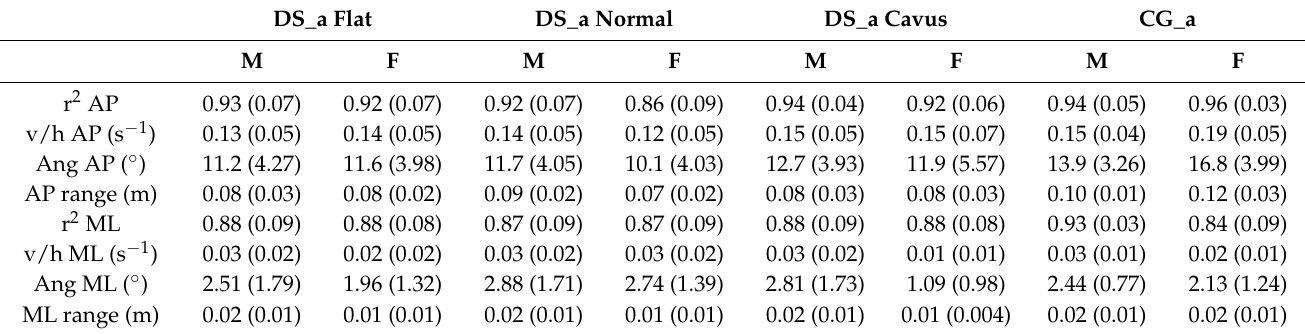
Table 3. Mean and standard deviation values of parameters extracted from the CoP in the antero– posterior (AP) and medio–lateral (ML) directions for healthy young adults and young adults with Down syndrome (DS). M, males; F, females; r 2 , coefficient of determination; v/h, mean velocity of the CoP normalized with respect to height; Ang, angle of inclination of the line interpolating the displacement of the analyzed CoP; range, range of the CoP (max coordinate–min